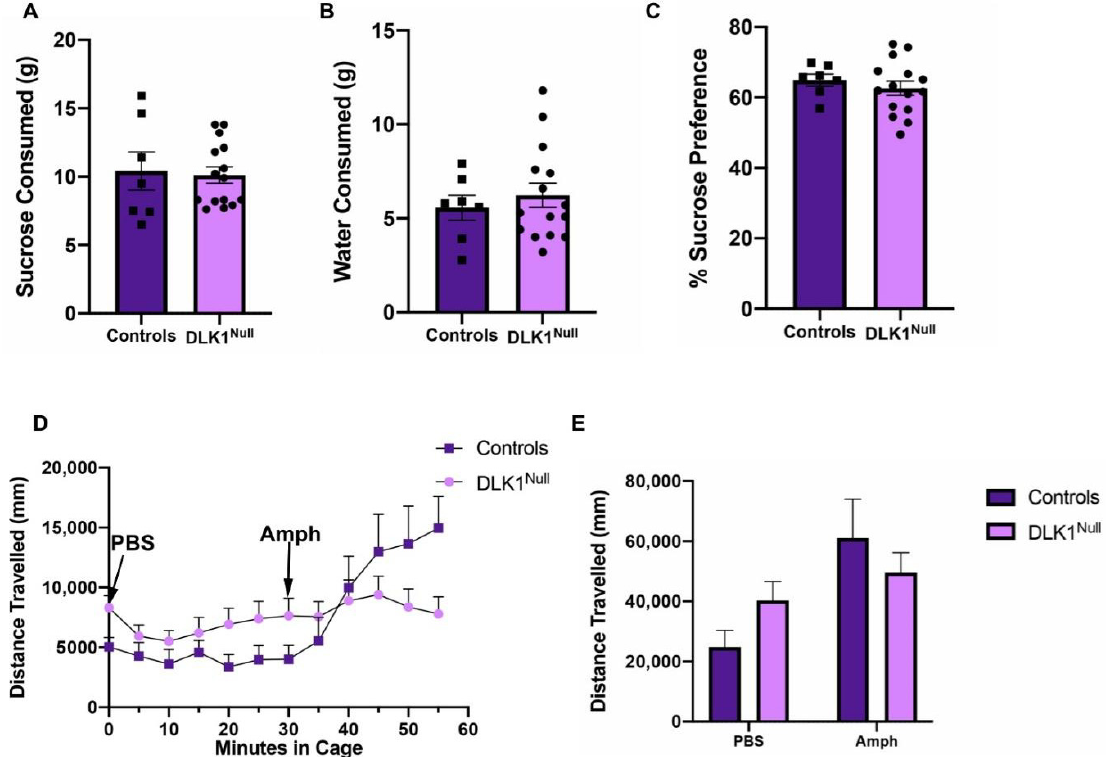
Figure 6. DLK1-deletion in the LHA does not alter natural reward behaviors. The amount of ( A ) 1% sucrose solution and ( B ) water consumed over 2 days in a two-bottle test. Bottles were weighed to assess consumption so values are expressed in grams (g). ( C ) DLK1 Null mice and control animals exhibit similar sucrose preference. ( D ) Distance traveled (mm) by mice in open field boxes over 60 min. Data points represent 5 min bins. Mice received a PBS injection at t = 0 min and an amphetamine injection at t = 30 min. (E) Total distance traveled (mm) after PBS and amphetamine injection. For ( A – C ), Control n = 7, DLK1 Null = 15. For ( D , E ), Control n = 6, DLK1 Null = 14.